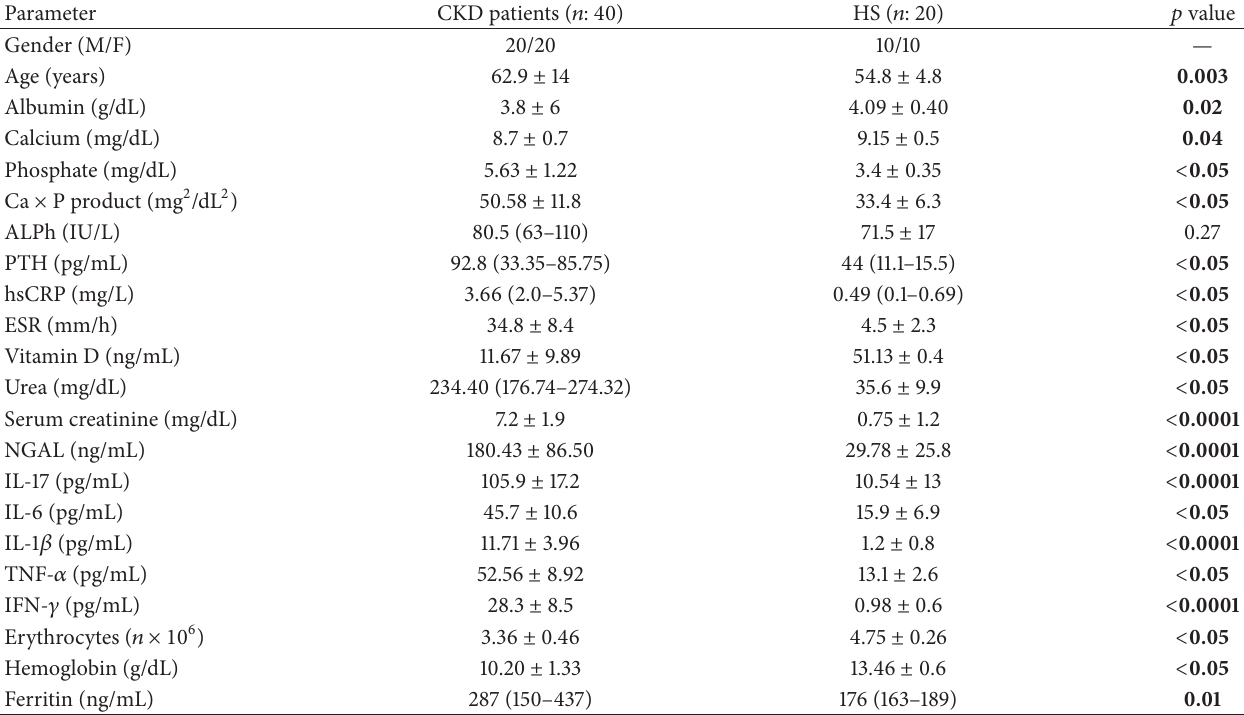
Table 1: Baseline demographic, clinical, and laboratory data of the study